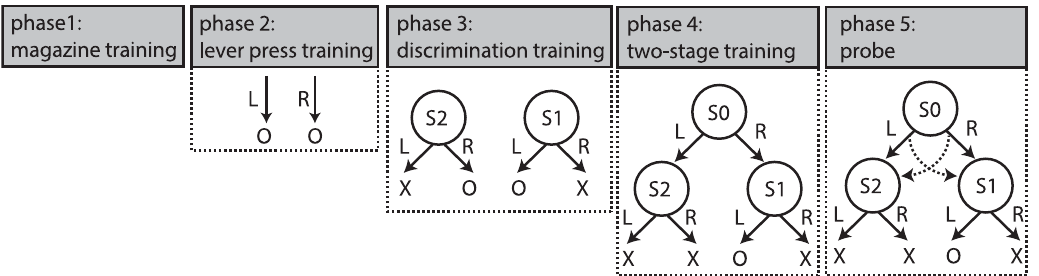
Fig 1. Different phases of the experiment. The experiment started with two magazine training sessions (phase 1), followed by several lever training sessions (phase 2), in which animals learned that pressing each lever (left and right levers corresponding to ‘L’ and ‘R’ in the figure) would delivered a reward (presented by ‘O’ in the figure). The next phase was discrimination training (phase 3), in which animals learned that when stimulus S1 was presented action ‘L’ should be taken to earn a reward, and when S2 was presented action ‘R’ should be taken to earn a reward. S1 and S2 were a constant and blinking house light, respectively. The next phase of the experiment was two-stage training, in which animals were trained on a two-stage decision-making task. This training phase comprised multiple training sessions and, in the middle or at the end of these training sessions, several ‘probe sessions’ were